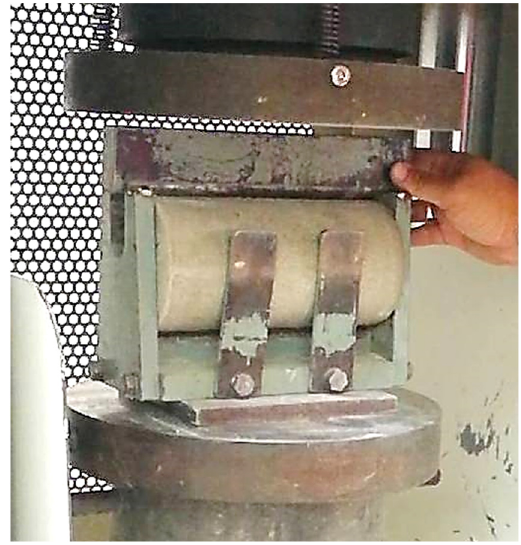
Figure 7. Splitting tensile test apparatus.